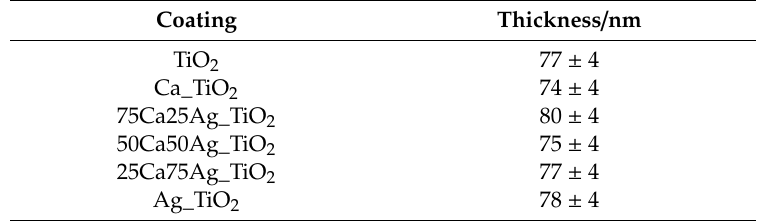
Table 2. The thickness of TiO 2 -based coatings doped with Ca and Ag ions in different molar ratios. Coating